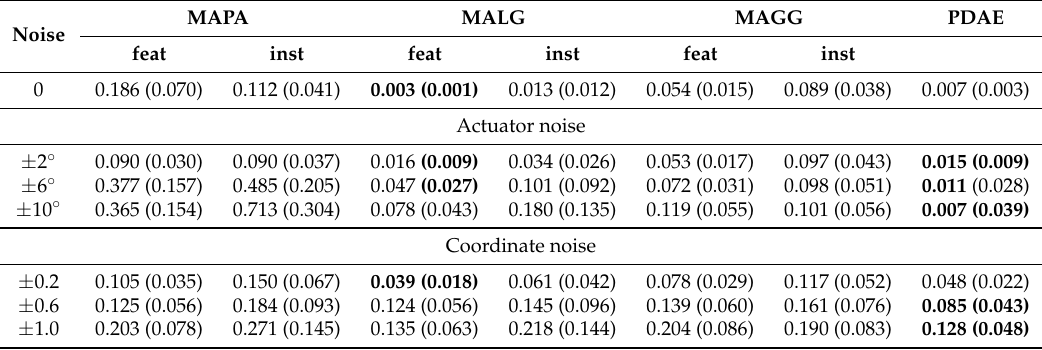
Table 2. 2D-2D manifold alignment: Shown are the alignment errors ∆ for the different alignment methods under different levels of noise. The standard deviation σ as defined as a measure of smoothness of the alignment in (5) is provided in parenthesis. The best results are highlighted in bold. MAPA MALG MAGG PDAE Noise feat inst